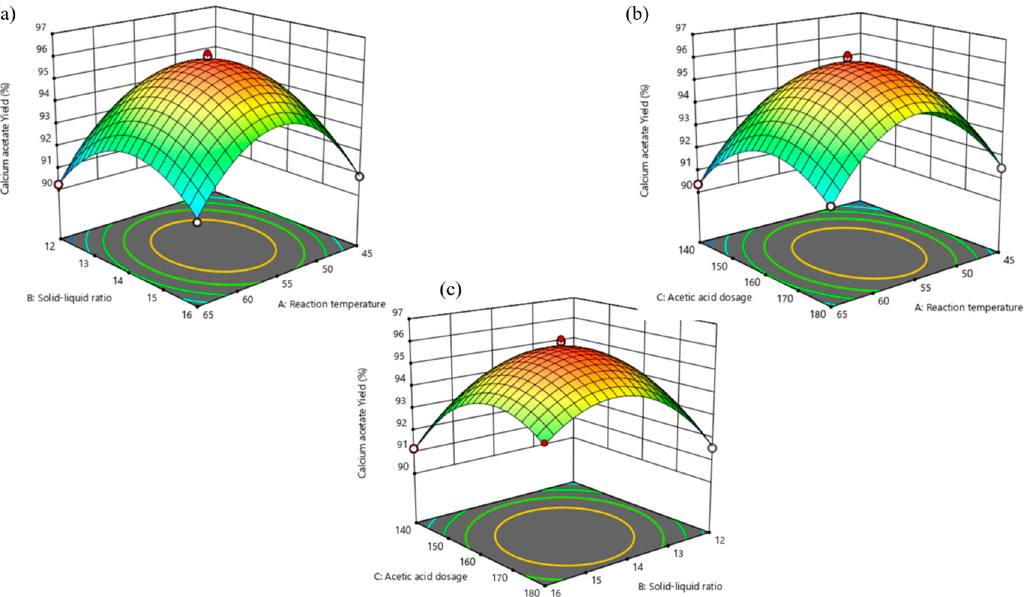
Figure 3. Three-dimensional response surface diagram of the interaction of various factors on the calcium acetate yield. ( a ) Temperature and Solid-liquid ratio, ( b ) Temperature and Acetic acid dosage, ( c ) Solid-liquid ratio and Acetic acid dosage. Table 4. Comparison of predicted value and actual values under optimal